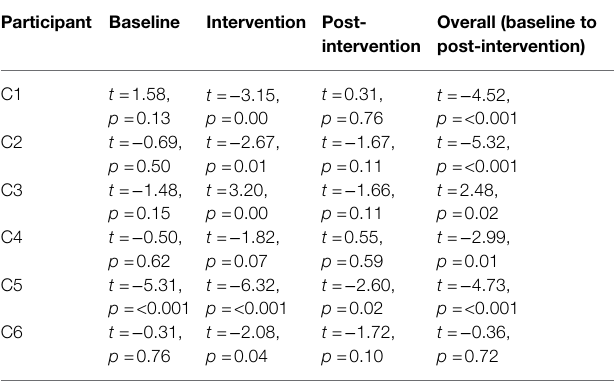
TABLE 3 | Time-series analysis results for participants C1–C6 using MoodMission